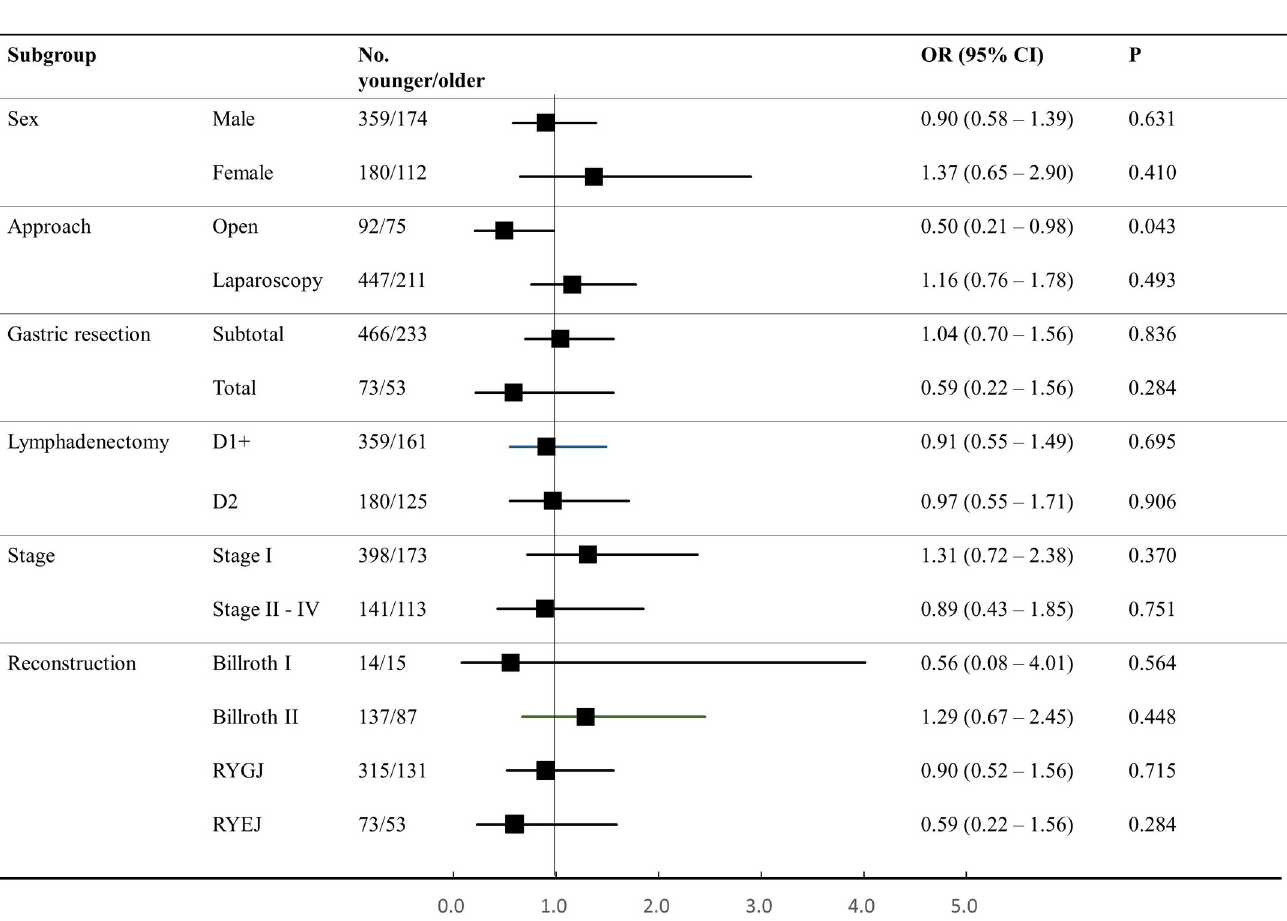
Fig 2. Intolerability in the older adult group in terms of different subgroups. The square box indicates the odds ratio for intolerability and the horizontal bar represents the 95% confidence interval. The older group showed no increase in intolerability in all subgroups. RYGJ, Roux-en-Y gastrojejunostomy; RYEJ, Roux-en- Y esophagojejunostomy.